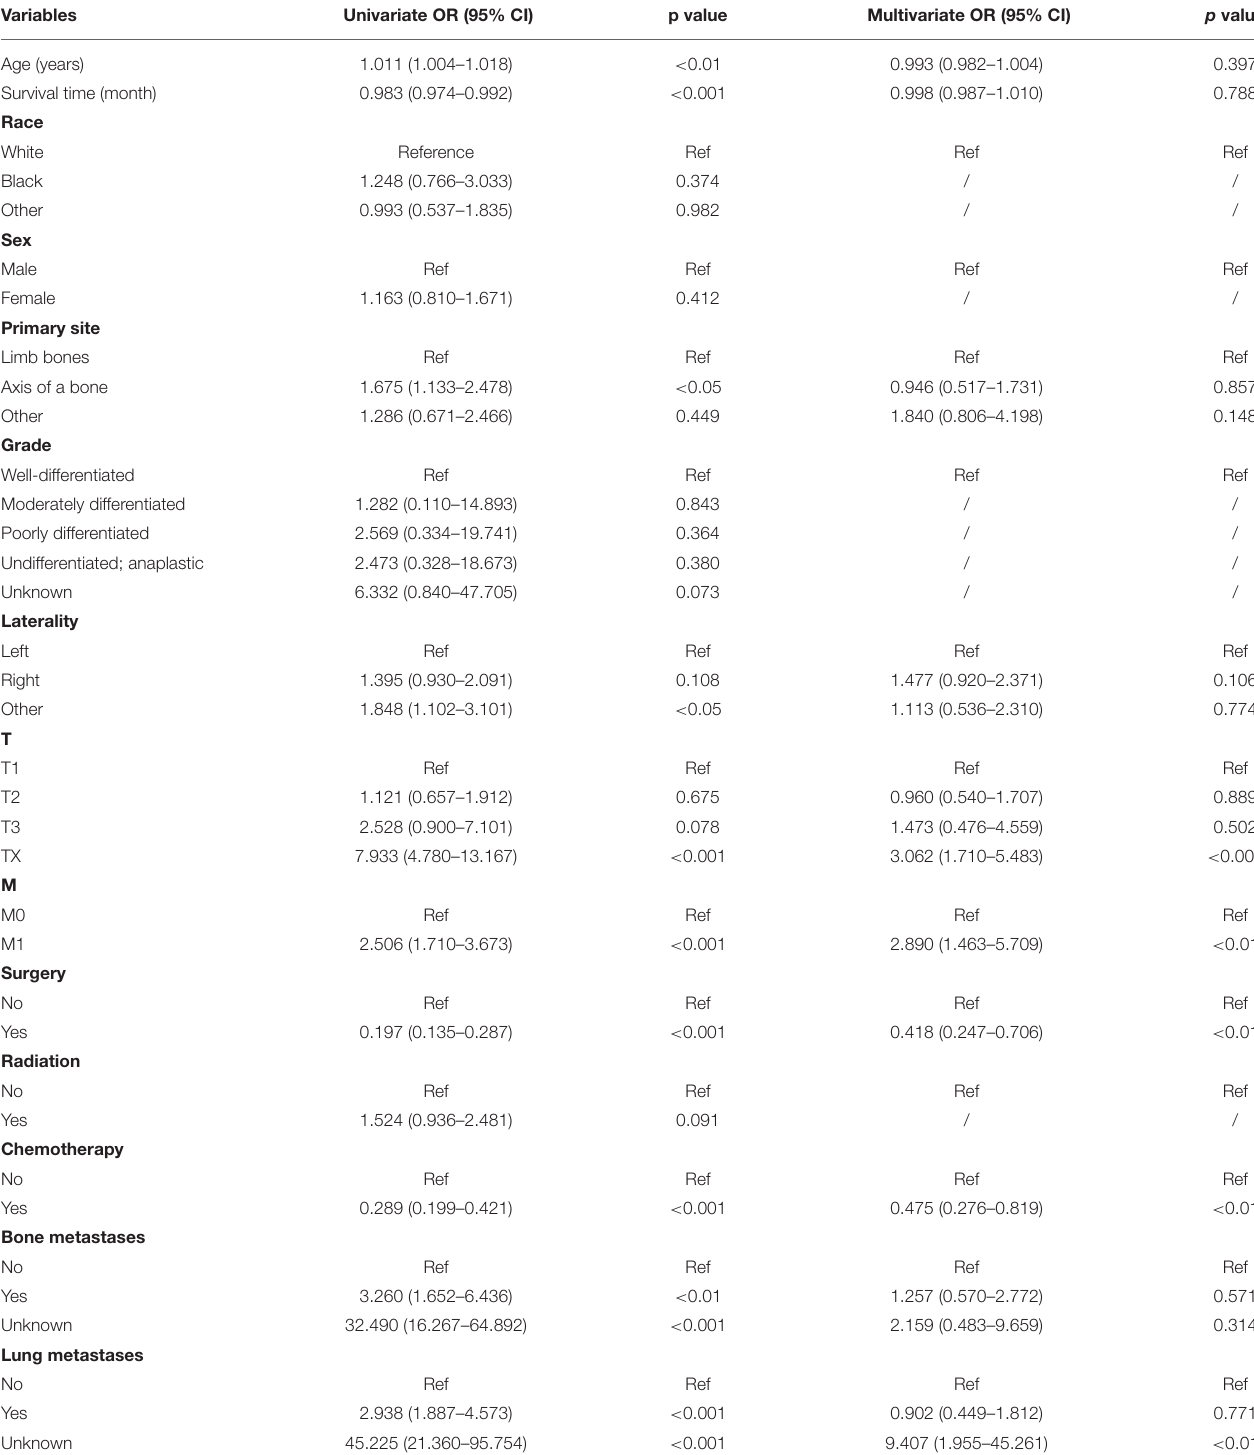
TABLE 3 | Univariate and multifactorial logistic regression analysis of risk factors for Lymph node metastases in patients with osteosarcoma. Variables Univariate OR (95% CI) p value Multivariate OR (95% CI) p